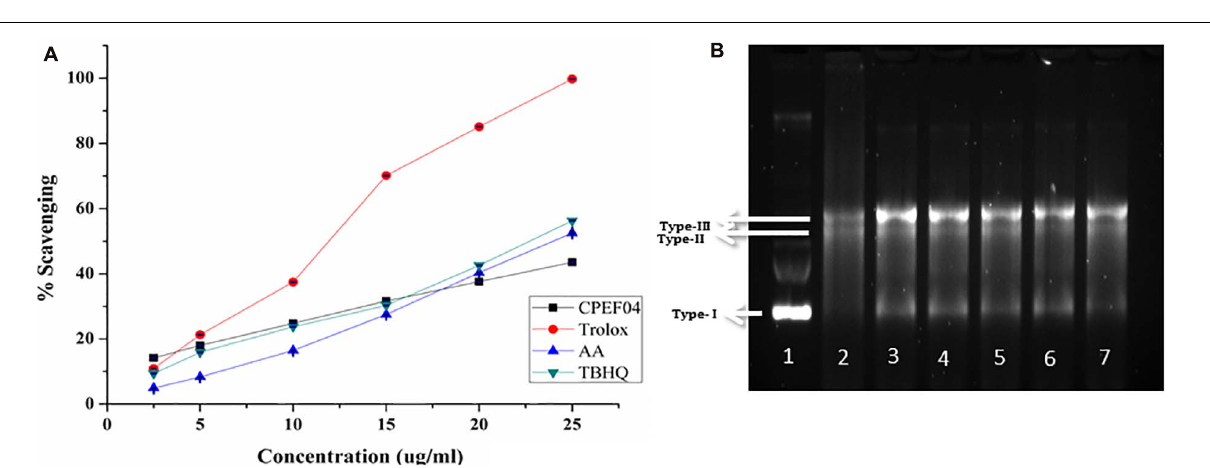
FIGURE 9 | (A) Antioxidant activity of the culture filtrate dried powder (CFDP) of isolate CPEF04 and standards (trolox, ascorbic acid, and tert-butylhydroquinone) against the 2,2 (cid:48) -azino-bis(3-ethylbenzothiazoline-6-sulfonic acid radical). (B) DNA nicking assay showing the protective effect of CPEF04 against the hydroxyl radical generated by Fenton’s reagent. Lane 1: native plasmid DNA pBSK not treated with Fenton’s reagent; lane 2: DNA treated with Fenton’s reagent; lane 3: DNA treated with Fenton’s reactant and 25 µ g/ml curcumin; lane 4–7: DNA treated with Fenton’s reactant and CPEF04 CFDP (200, 100, 50, and 25 µ g/ml,